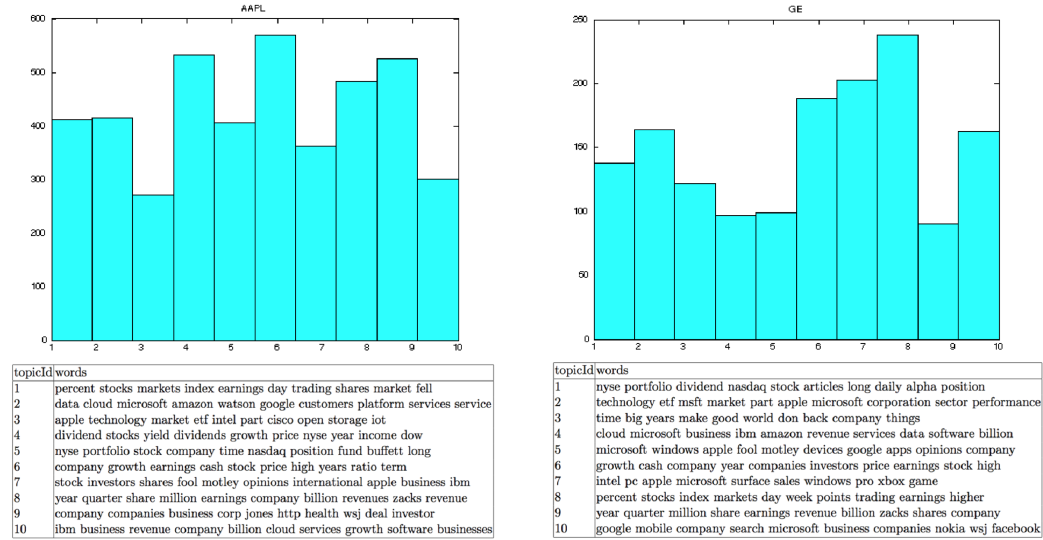
Figure 13. Topic modeling for AAPL and GE stocks. The y -axis represents the number of texts in each topic, and the x -axis represents the